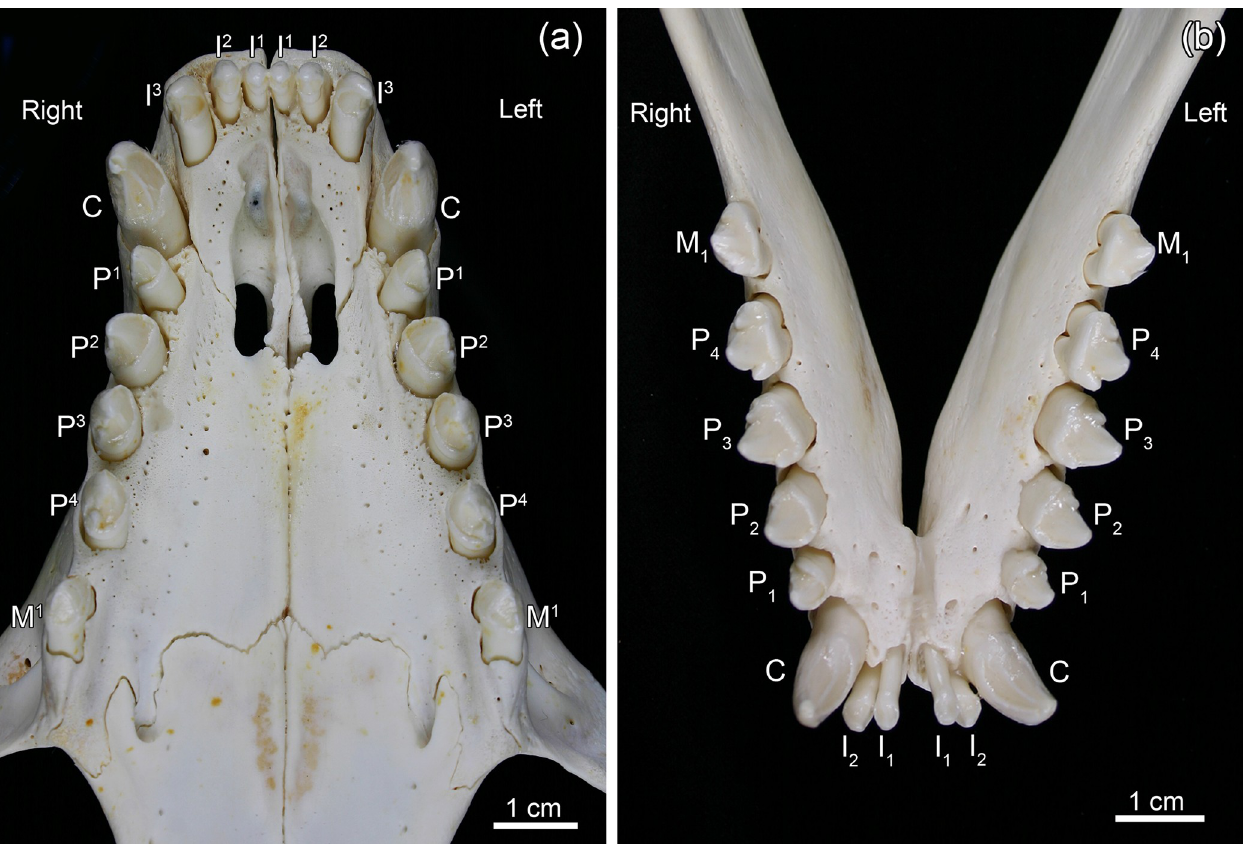
Fig 1. Permanent dentition of a Baltic grey seal ( Halichoerus grypus grypus ; specimen ZMUC CN 1157, juvenile male). (a) Maxillary dentition. (b) Mandibular dentition.